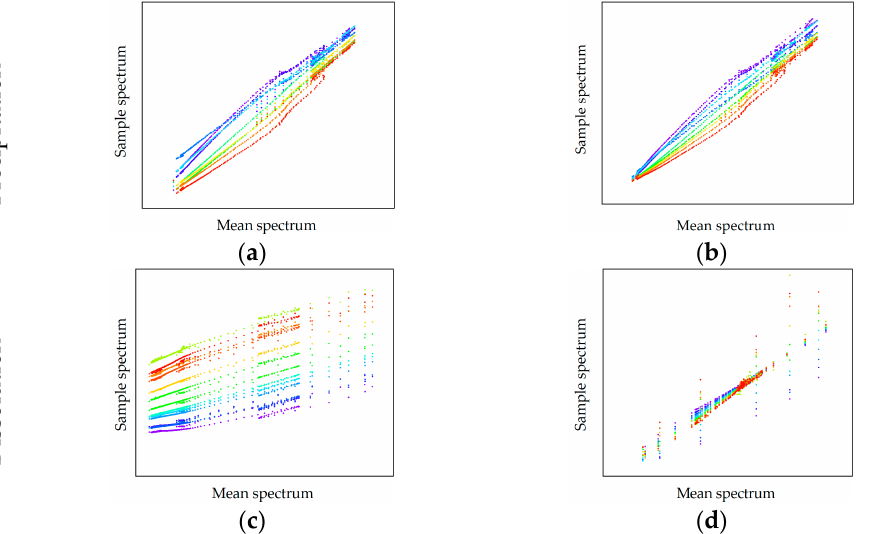
Figure 13. Diode array detector (DAD) scatter effects plot for evaluation of needed preprocessing of spectral data. ( a , c ) show scatter effects of raw spectral data and ( b , d ) show scatter effects after preprocessing.